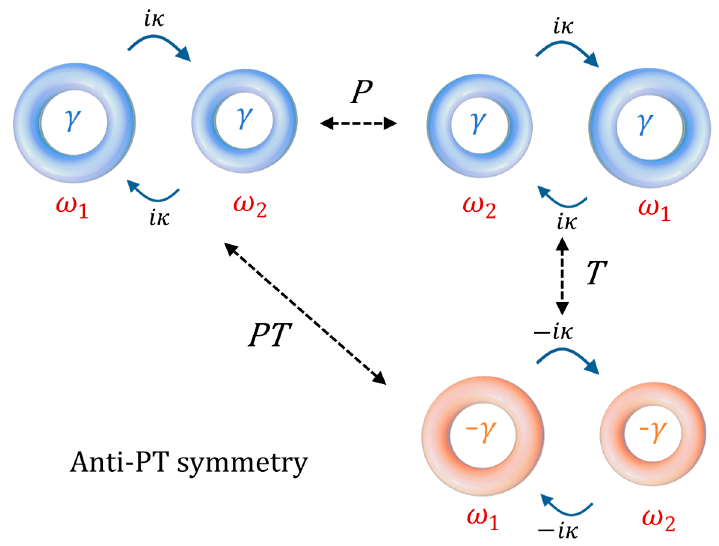
Figure 3. Graphical interpretation of anti PT symmetry in coupled resonators.